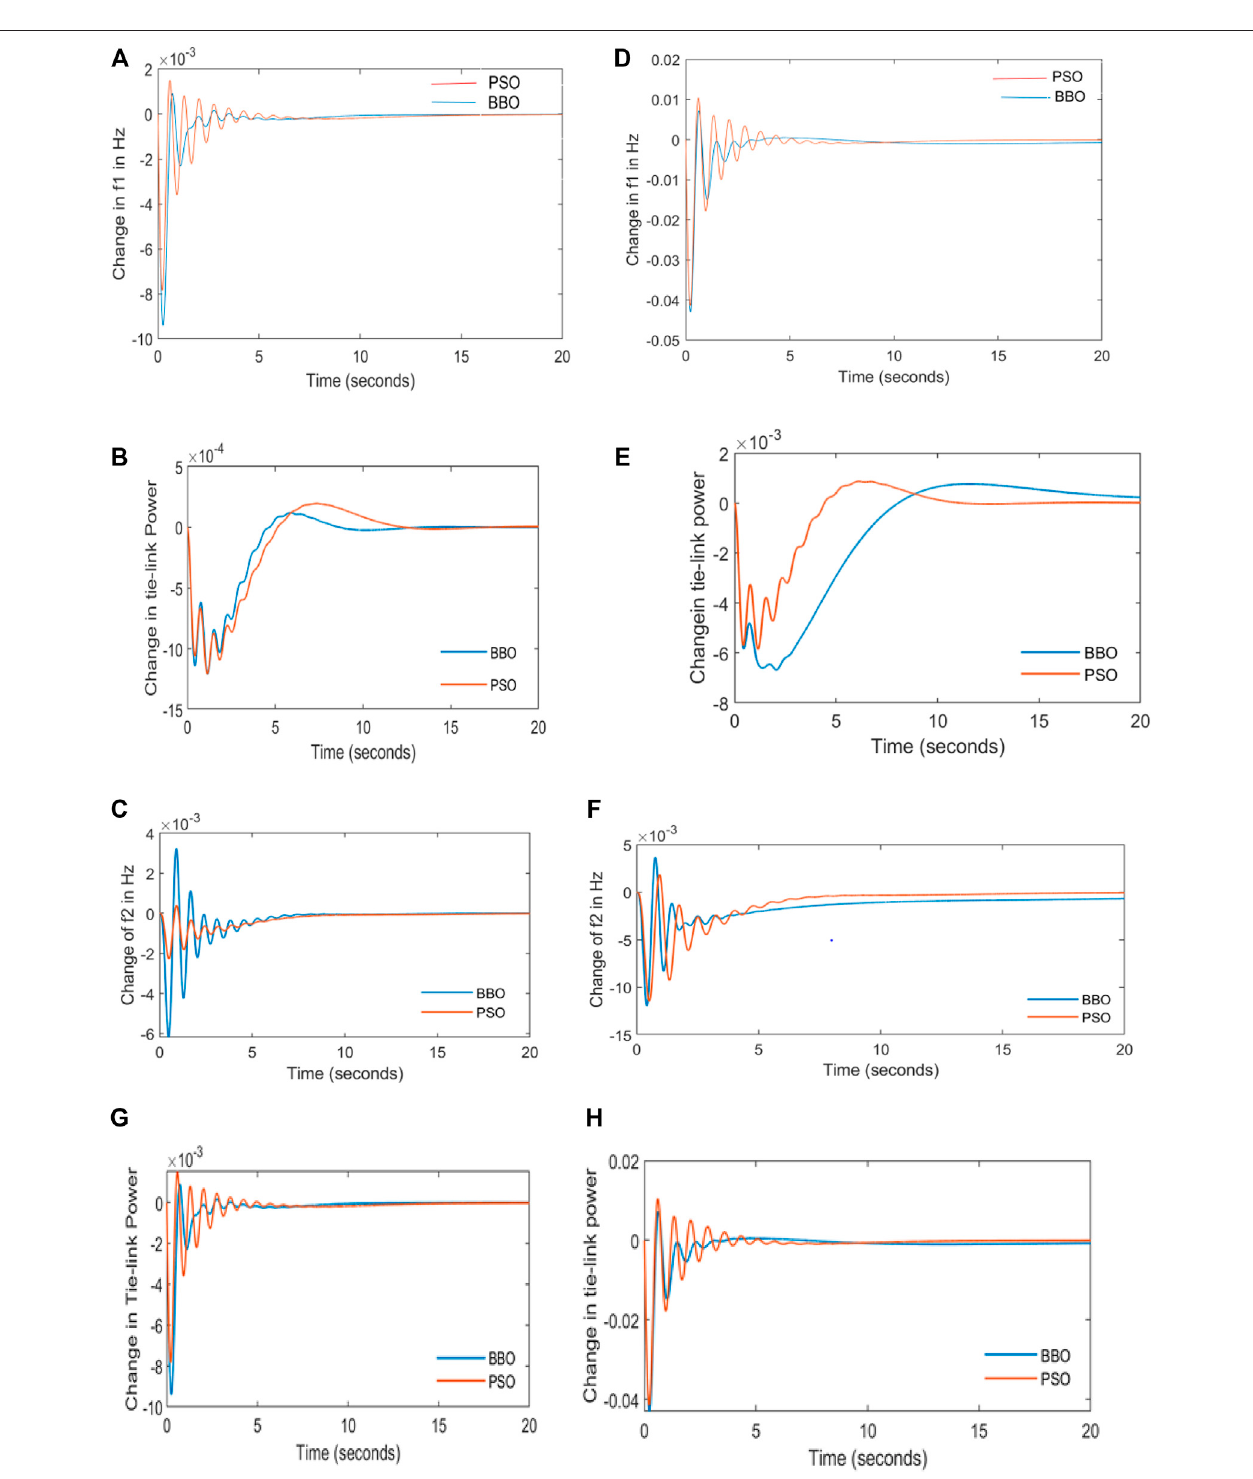
FIGURE 2 | Dynamics of Area-1 and Area-2 with and without HESS for 1% and 5% change in load with HVDC link. (A) Dynamics of f1 at 1% Load Change with HESS. (B) Dynamicsof Ptie at 1% Load Change with HESS. (C) Dynamics off2 at 1% Load Change with HESS. (D) Dynamics of f1 at 5% Load Change with HESS. (E) Dynamics of Ptie at 5% Load Change with HESS. (F) Dynamics of f2 at 5% Load Change with HESS (G) Dynamics of Ptie at 1% Load Change without HESS. (H) Dynamics of Ptie at 5% Load Change without HESS.